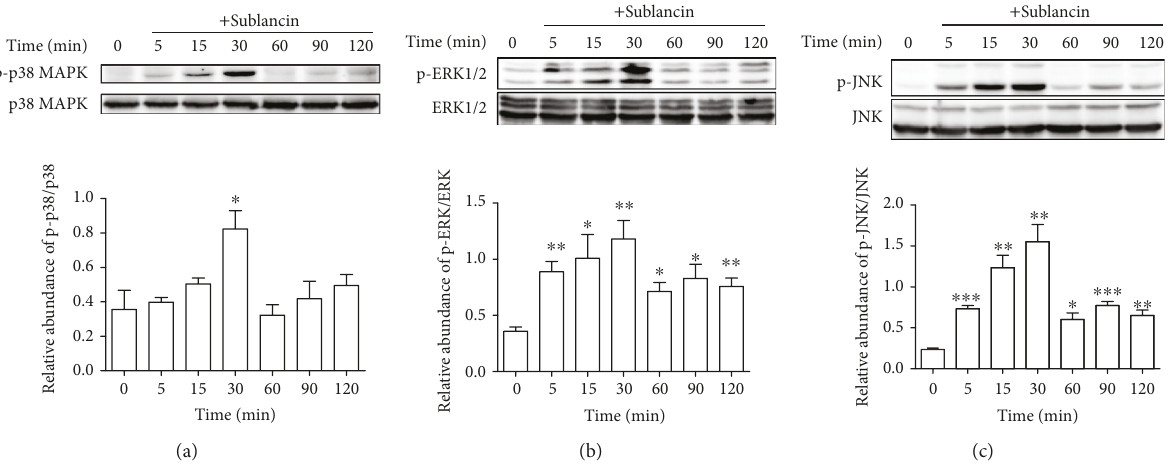
Figure 3: Analysis of p38, ERK, and JNK signaling pathways in RAW264.7 cells treated with sublancin for di ff erent times. RAW264.7 cells were treated with 100 μ M sublancin for the indicated times, and the phosphorylation of p38, ERK1/2, and JNK were detected by Western blot analysis. Representative immunoblots and quantitation of the phosphorylation abundance of p38 (a), ERK1/2 (b), and JNK (c). The values are presented as mean ± SEM ( n = 3 ). Signi fi cant di ff erences with control cells were designated as ∗ P < 0 05 , ∗∗ P < 0 01 , or ∗∗∗ P < 0 001